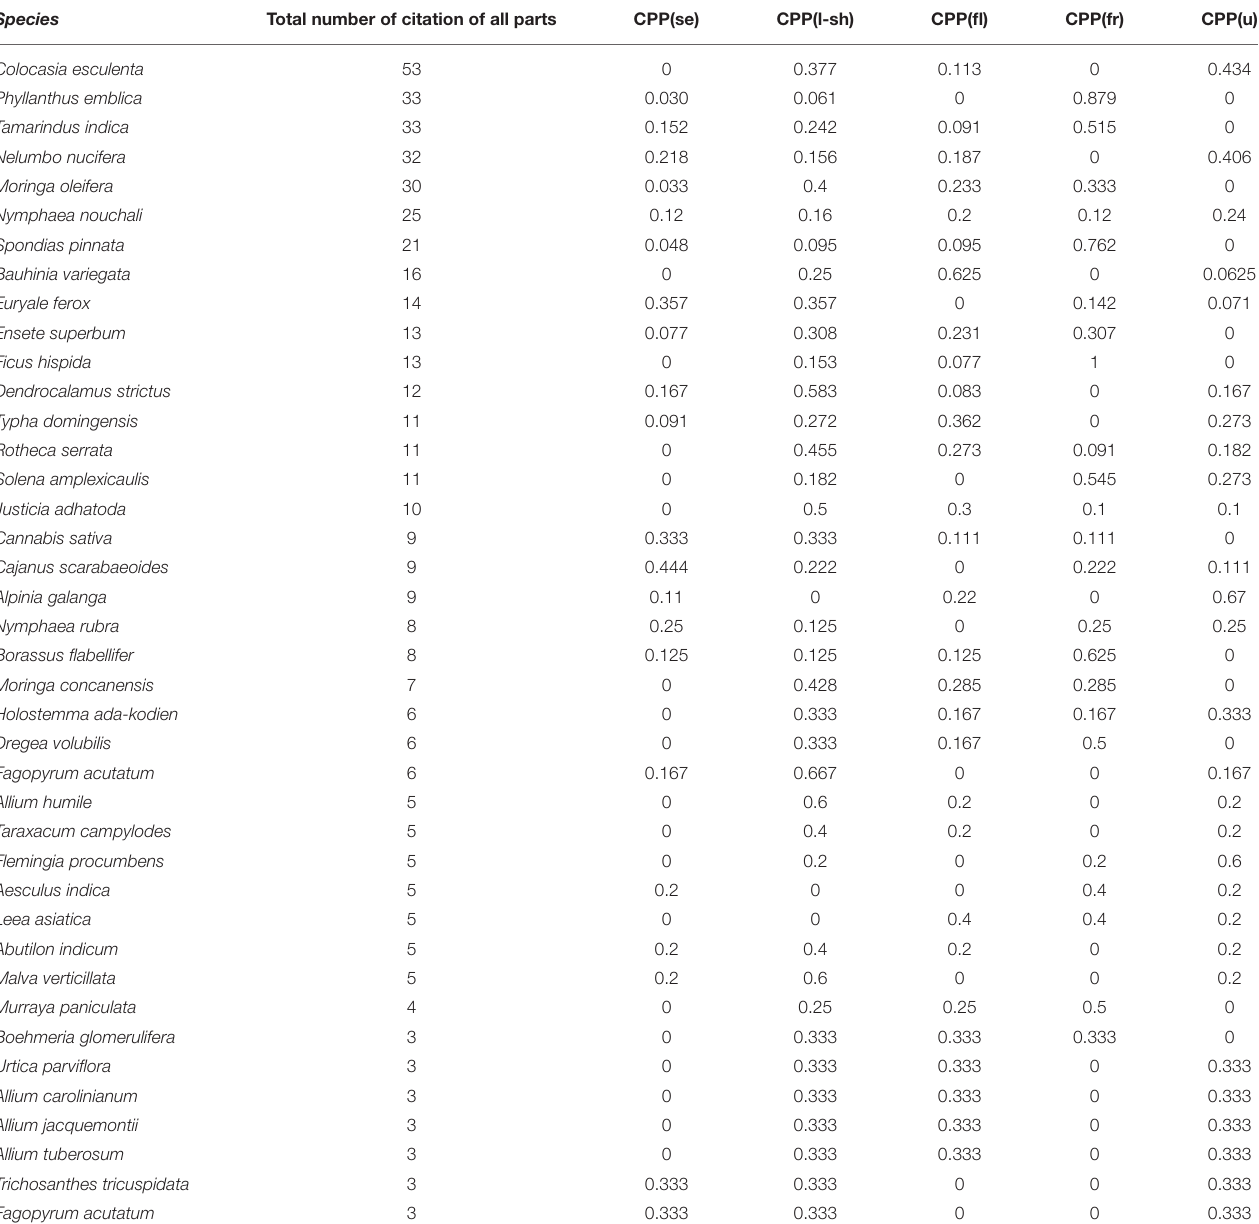
TABLE 4B | CPP value for selected plants with RUV value between 0.5 and 1.